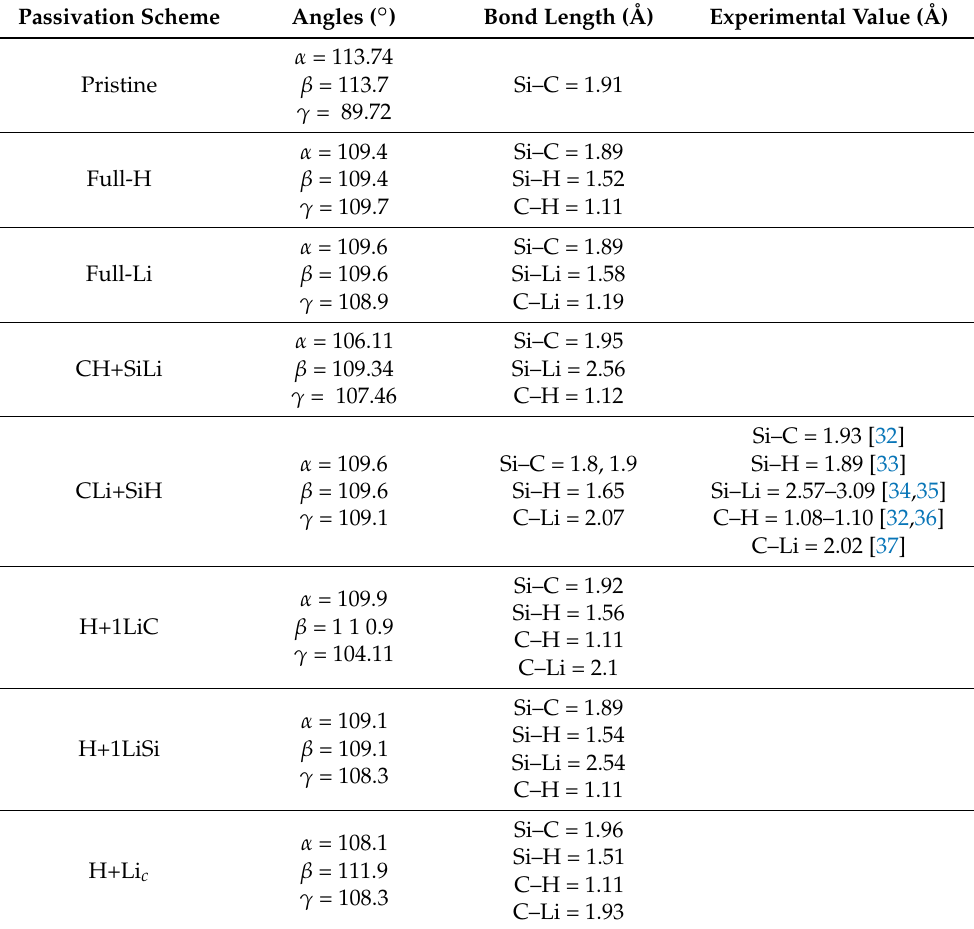
Table 2. Bond lengths between atoms involved in close interaction Si–C, Si–H, Si–Li, C–H, C–Li and the experimental